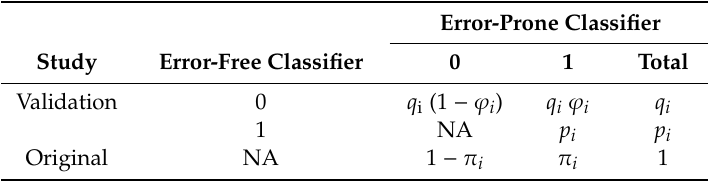
Table 2. Cell Probabilities for group